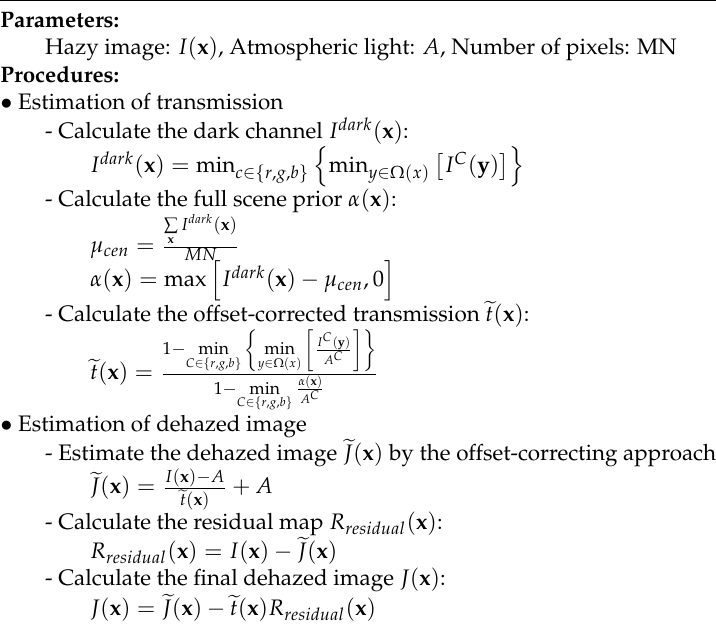
Table 1. Dehazing algorithm implementation with offset correction and a weighted residual